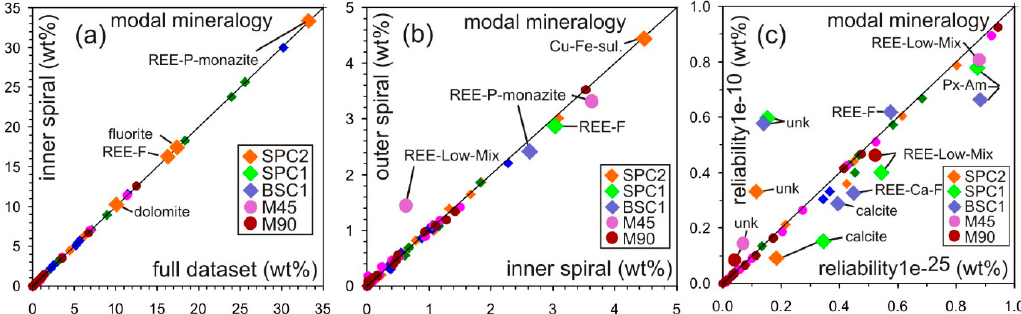
Figure 7. Influence of various parameters on the modal mineralogy of processed REE carbonatite ores. Datasets from single samples are based on the analysis of 300,000–600,000 particles in epoxy grain mount blocks of 30 mm in diameter. Samples are: SPC2—second cleaner concentrate; SPC1—scavenger cleaner concentrate; BSC1—scavenger cleaner middlings; BS1—scavenger tailings; M45, M90 are samples of comminution test with 45 and 90 min of milling. See legend insets. ( a ) Comparison of full dataset composed by inner and outer spiral of measurement frames vs. inner spiral, in the scale 0–35 wt %. At this scale a measurement of the inner spiral appears as su ffi cient. ( b ) Comparison of the inner spiral vs. the outer spiral of measurement frames, in the scale 0–5 wt %. Although some outliers with low modes exist, the epoxy block displays homogeneous distribution of particles. ( c ) Influence of the parameter reliability of conformity of EDX spectra during measurement classification against reference spectra set. The values of reliability of conformity are intermediate (1 ℮ − 25 ) and high (1 ℮ − 10 ) and refer to grouped spectra. A high reliability of conformity leads to a significant increase of “unknown” (unk) which is only relevant for modes between 0 and 1 wt %.